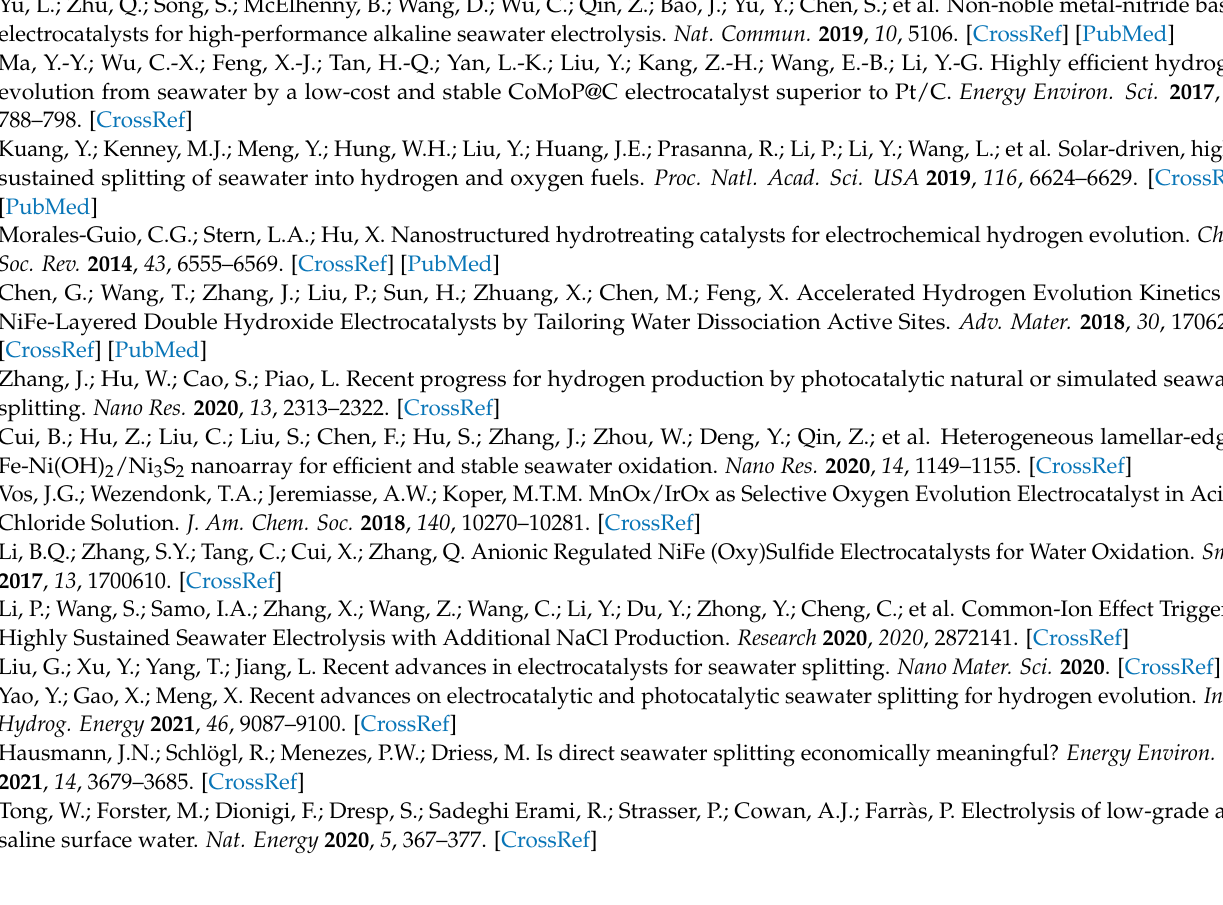
Diagram of oxygen evolution Faraday Efficiency test device. Table S1: The main compositions in natural seawater. Table S2: OER performance comparison of BSCF with other perovskites. Table S3: Comparison of the OER activities of the different types of perovskite composites in this work and the other reports